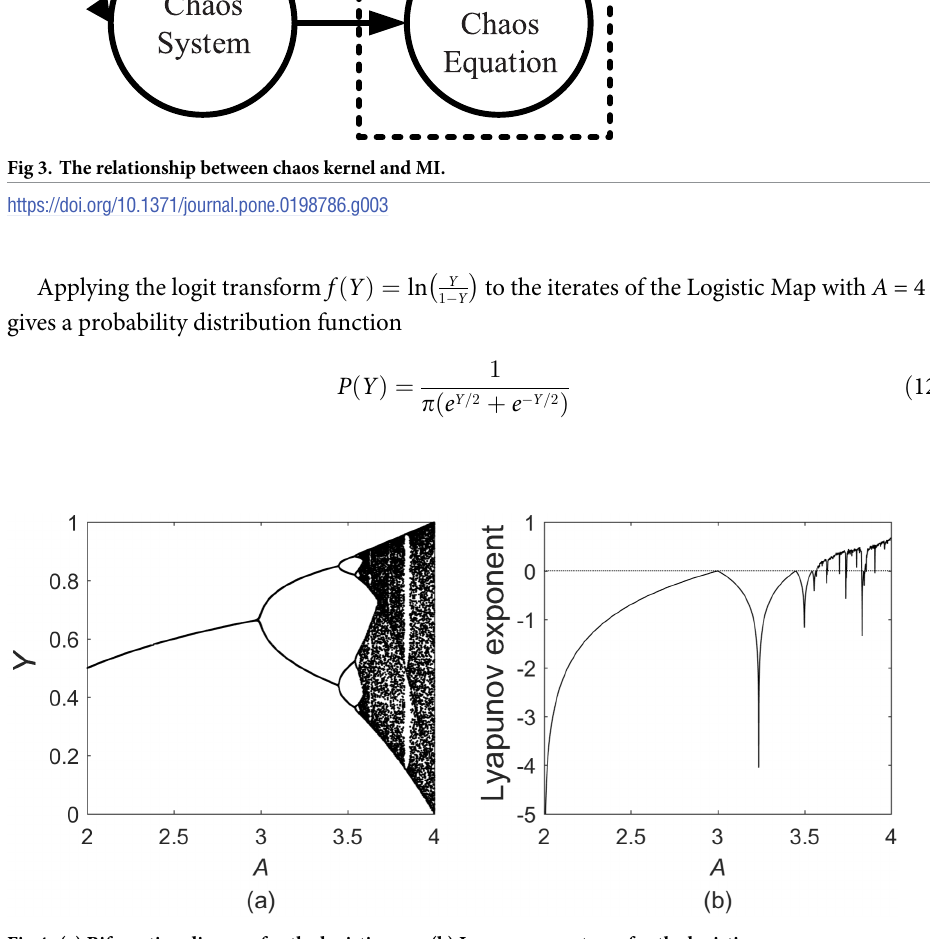
Fig 4. (a) Bifurcation diagram for the logistic map; (b) Lyapunov spectrum for the logistic